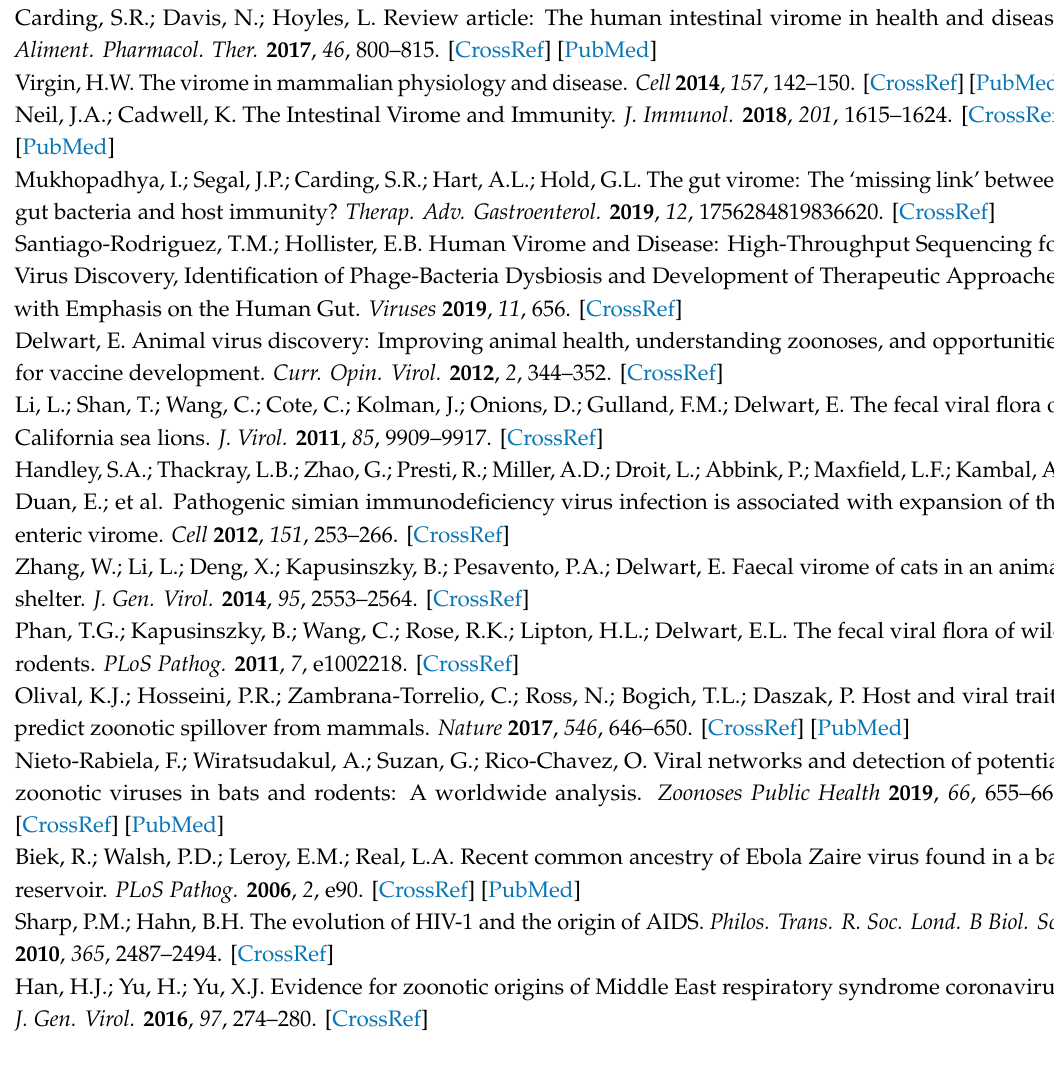
Table S1: The percentage of amino acid identity between novel picornaviruses and closely related picornaviruses in P1, 2C + 3CD regions, Table S2: The pairwise amino acid identity of NS1 protein between novel mafachavirus 1A and closely related chapparvovirus, Table S3: The sequence conserved functional motifs within Rep protein of Macaca fascicularis stool-associated virus ( Mafasavirus ), Figure S4: The alignments of viral contigs from Macaca fascicularis compared to the reference sequences of viruses from NCBI, Supplementary File 1: The metadata of macaque samples, Supplementary File 2: The summary table of reads processing and data